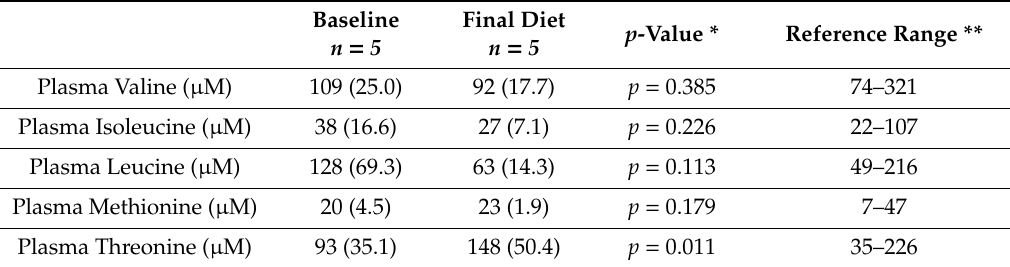
Table 3. Paired sample t-test results of plasma propiogenic amino